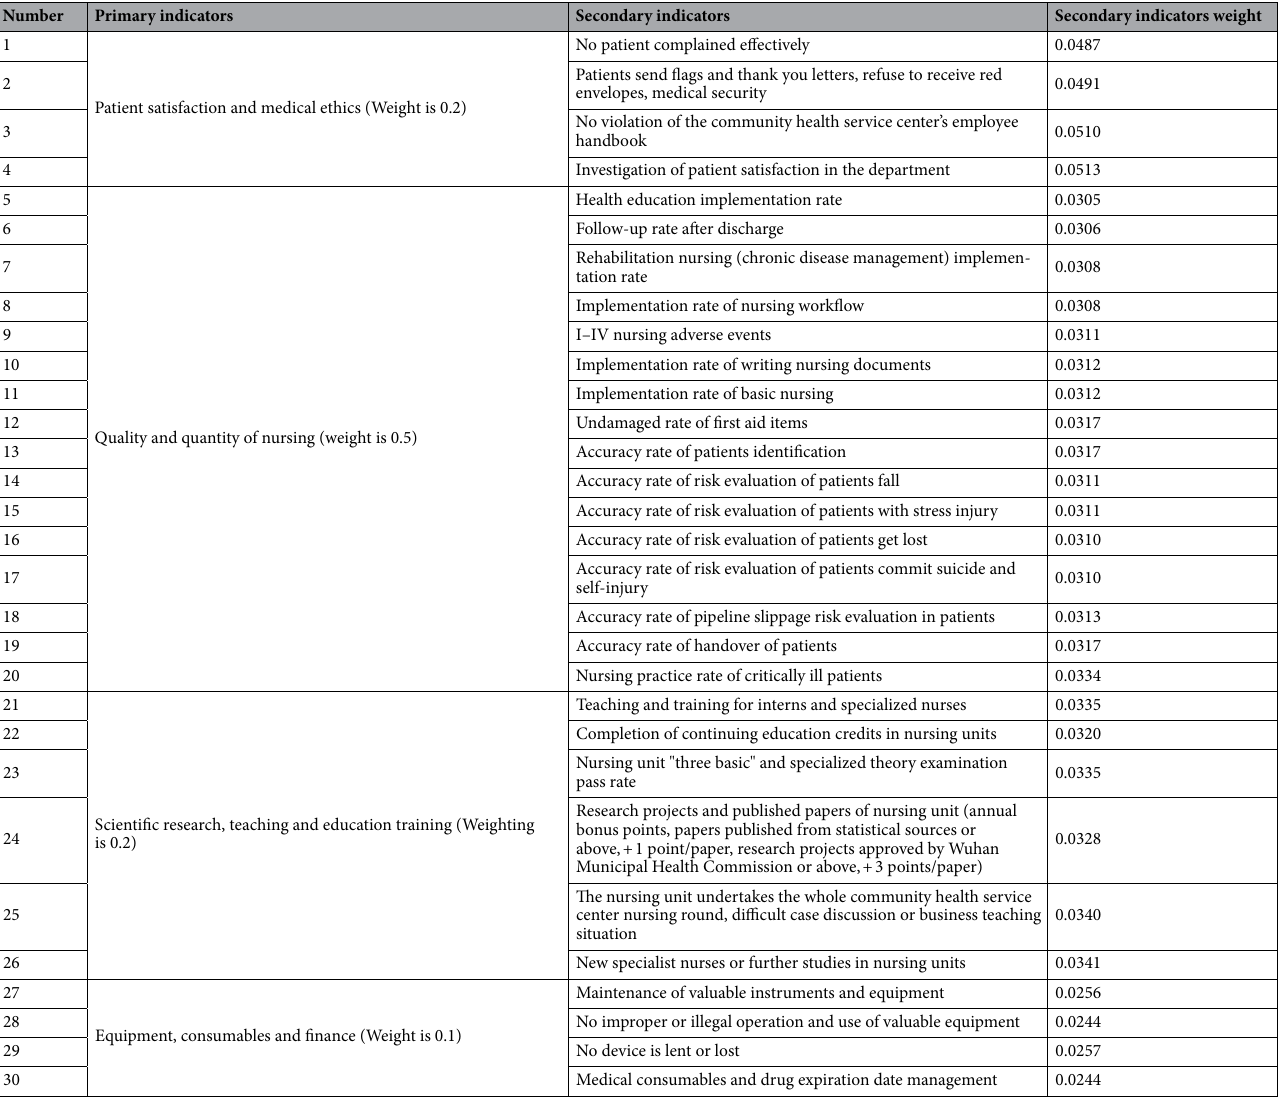
Table 3. Nursing unit performance evaluation